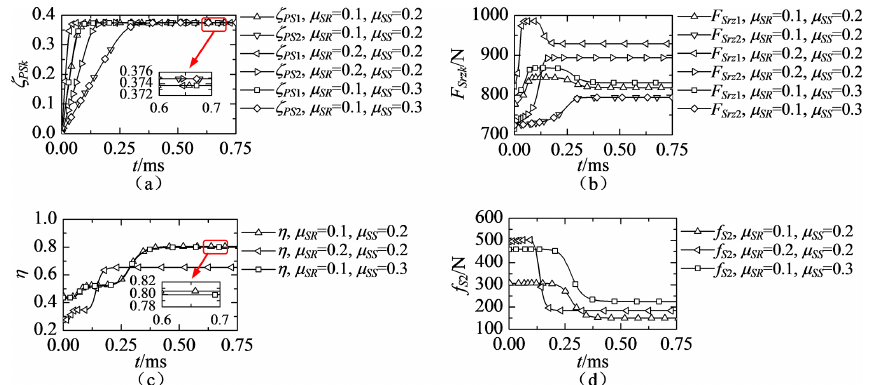
Figure 4. Influence of friction coefficients on (a) rotational velocity ratios, (b) axial component of the contact force at the screw # k –roller # k interface, (c) efficiency and (d) friction force between screw #2 and screw #1.